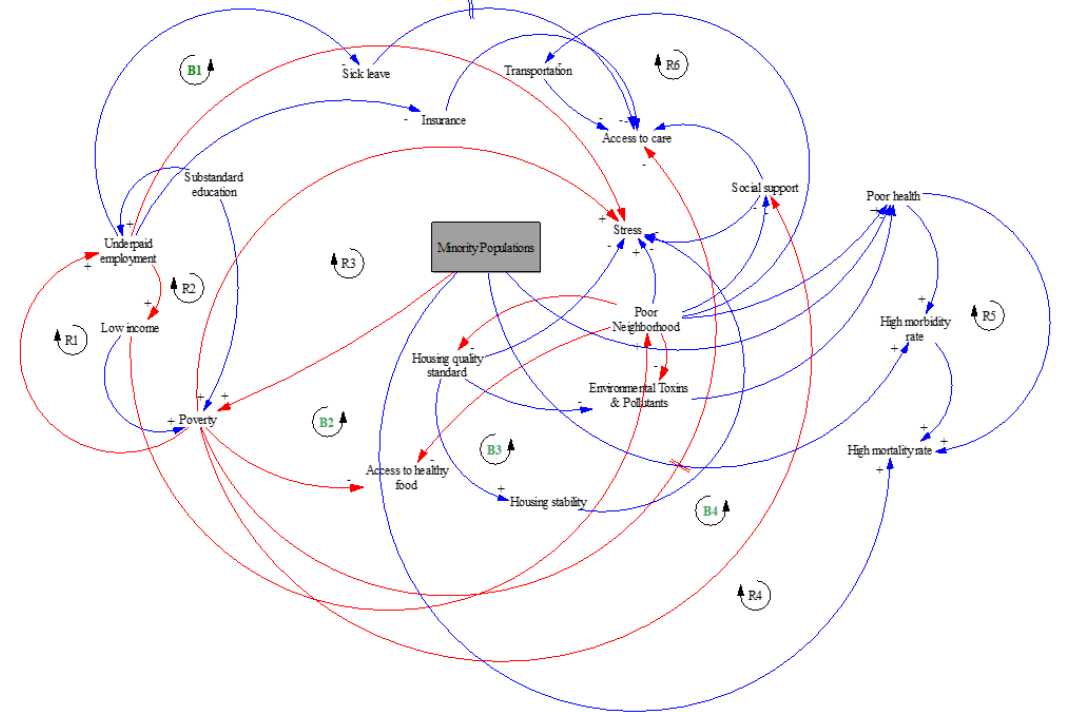
Figure 1. The Causal Loop Model for the Influence of Social Determinant of Health on the Minority Populations. This diagram shows how social determinant of health factors impacts the incidence and the prevalence of CKD in the minority populations, with the reinforcing (R) loops and balancing (B) loops displayed. The red colored arrows represent the disparities, and the blue arrows signify the usual and general influence of social factors on the health of the